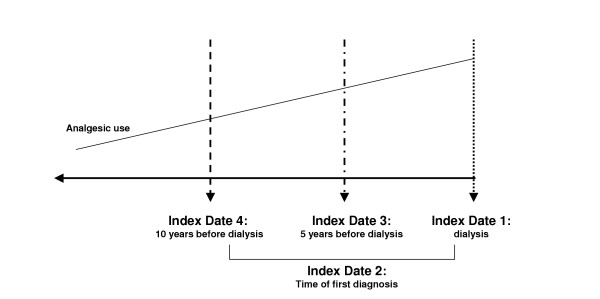
Index dates and relationship with putative analgesic use in the SAN case-control study.